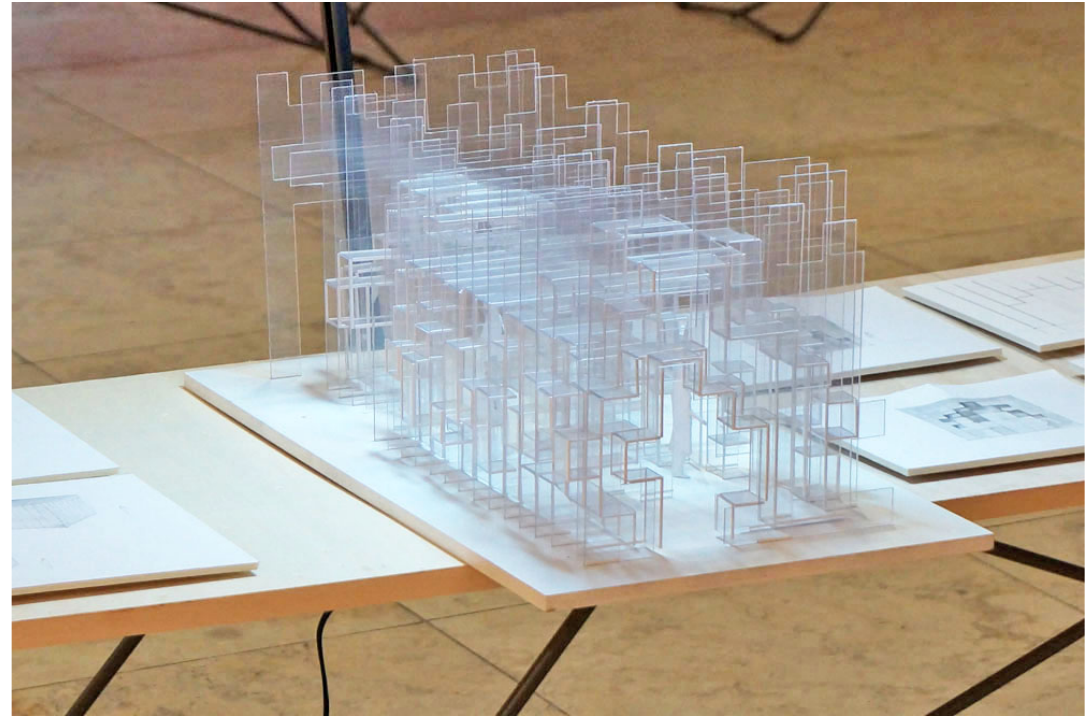
Fig. 1: Modell of Voxel structure of exhibition